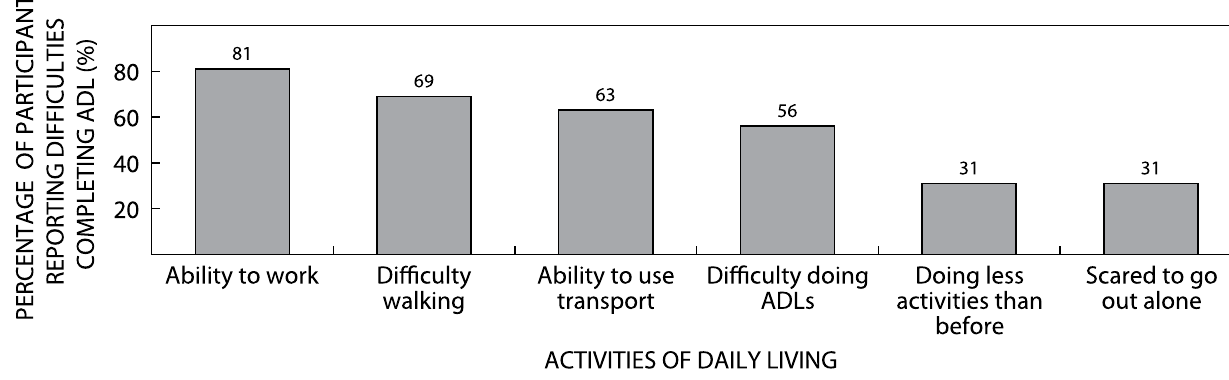
Figure 4: The psychological effect that vestibular symptoms had on participants experiencing vestibular symptoms ( N = 16).